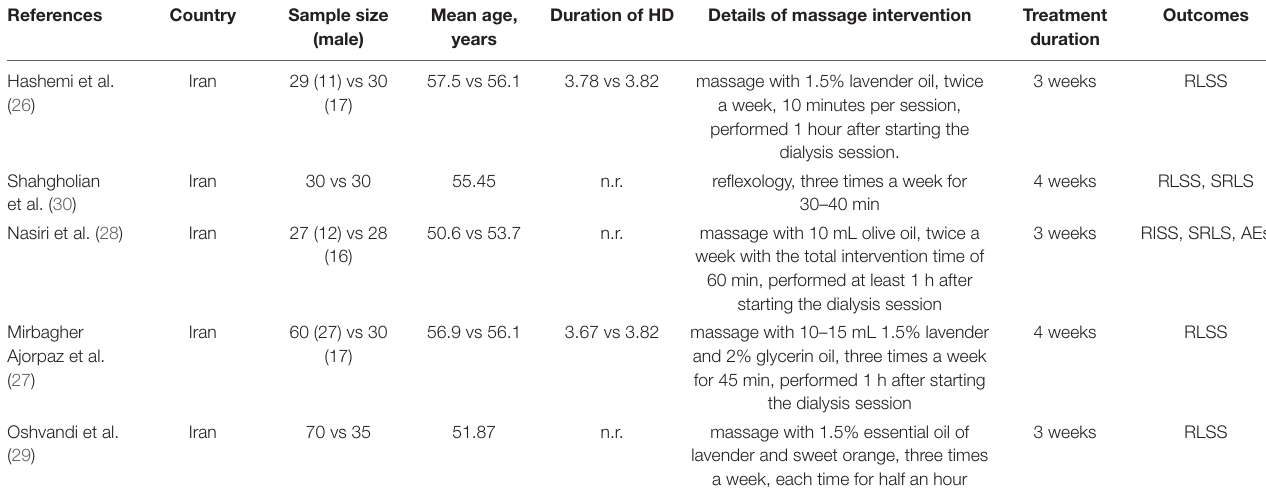
TABLE 1 | Characteristics of included studies (n = 5).